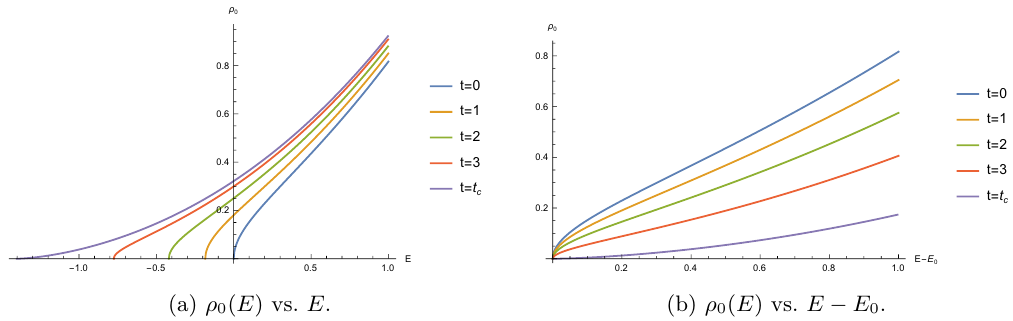
Figure 6 . Plot of ρ 0 ( E ) against (a) E and (b) E − E 0 for anti-FZZT branes. We set ξ = 18 in this